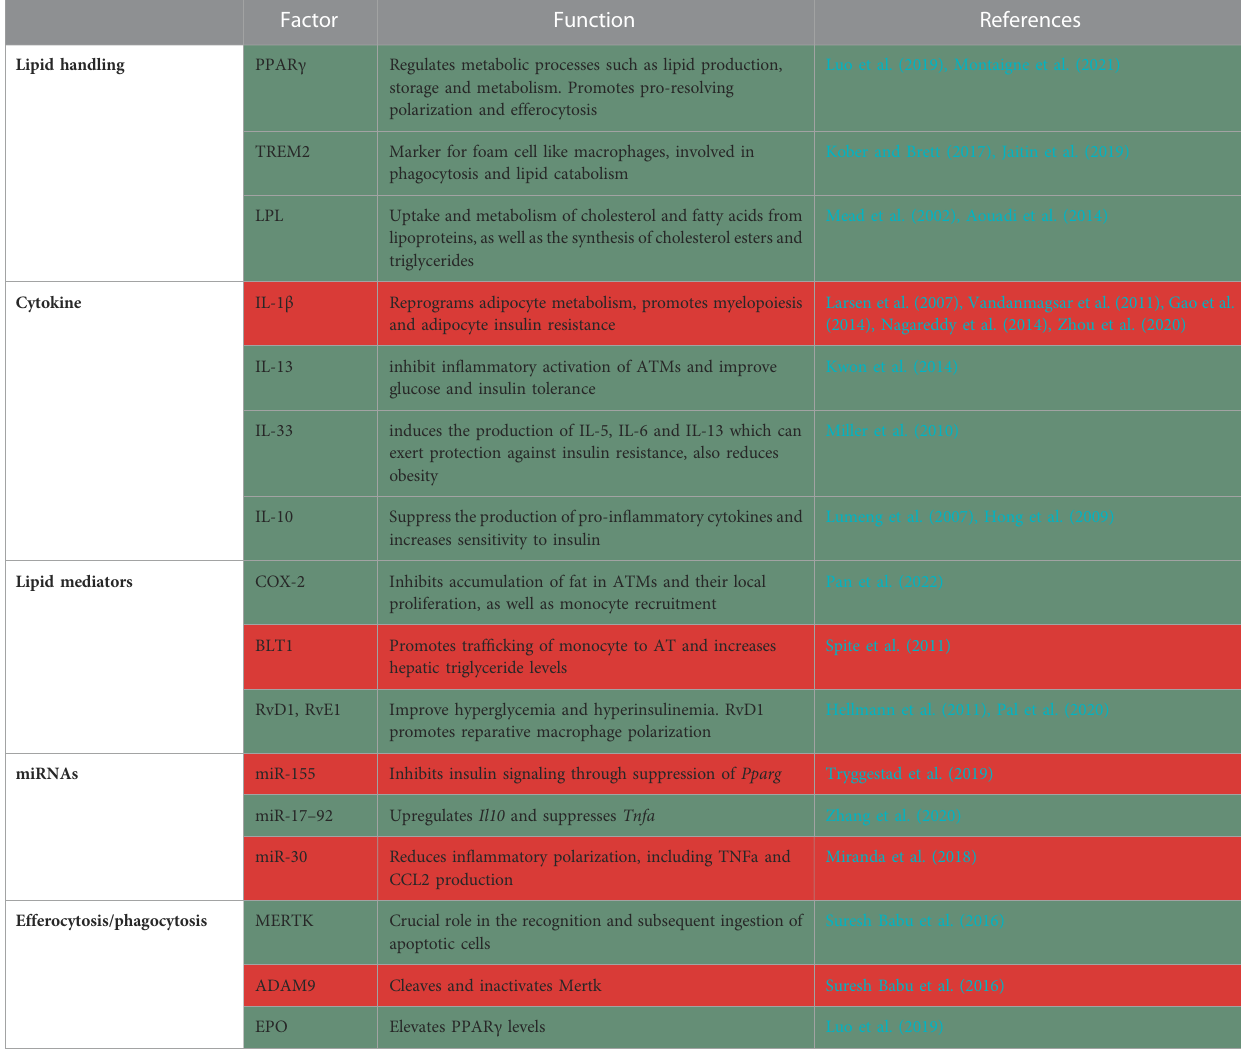
TABLE 1 Summary of factors in macrophages that protect from (green) or promote (red) adipose tissue in fl ammation and insulin